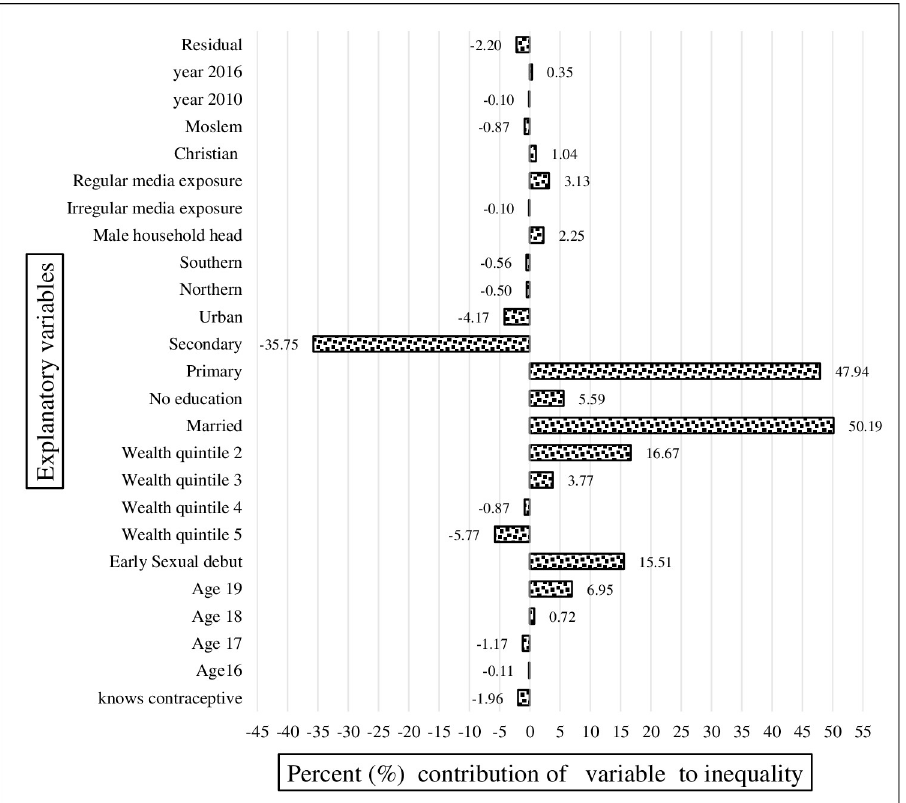
Fig 5. Decomposition of the concentration index for the pooled data. Constructed by authors from MDHS 2004, 2010, 2016.